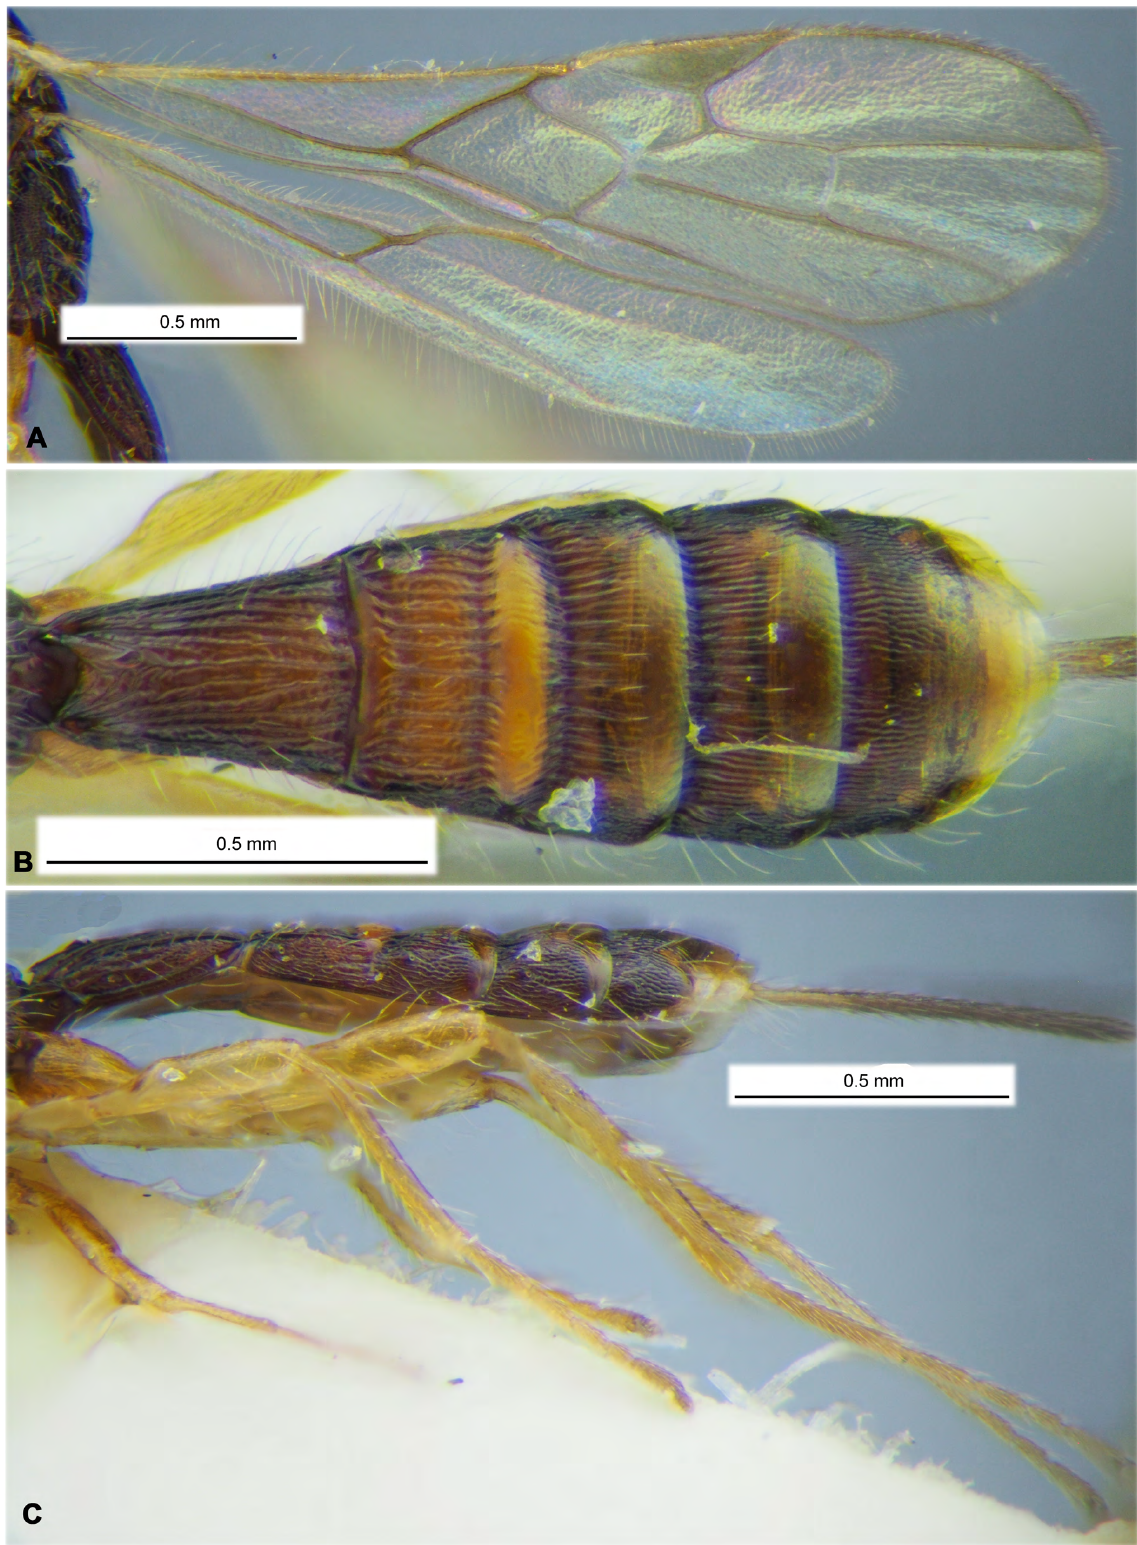
Fig. 11. Euryphrymnus basoareolus (Belokobylskij, 2001) comb. nov., ♀, holotype, ZISP. A . Wings. B . Metasoma, dorsal view. C . Metasoma and ovipositor, lateral